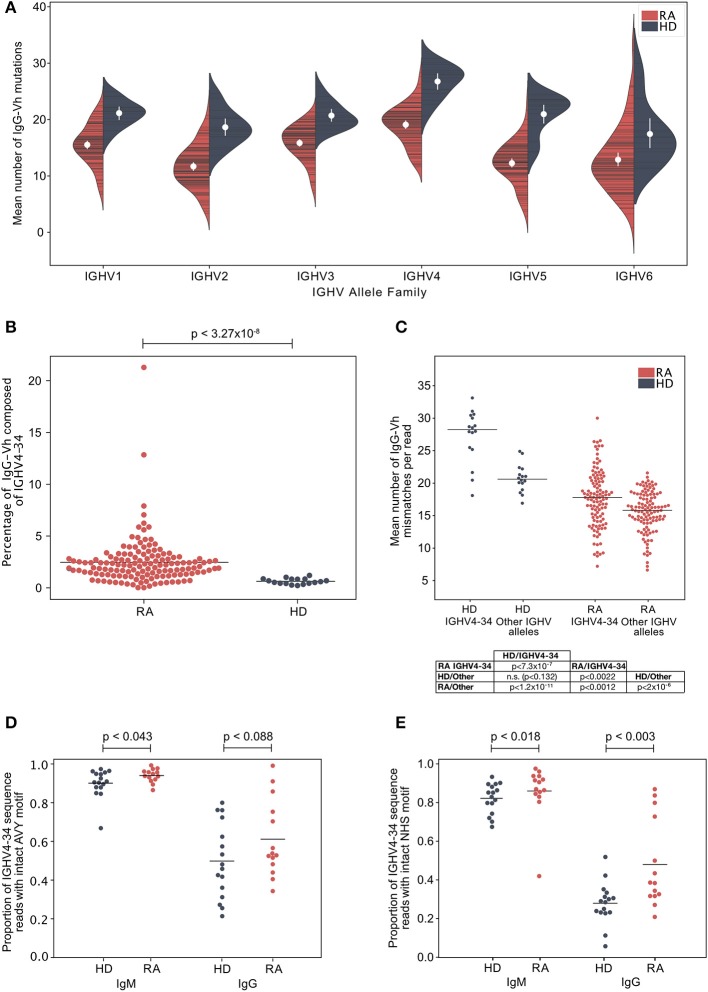
(A) The mean number of IgG-Vh V segment mismatches per read for each individual in the ERA (cohort 2, n = 113) and healthy control groups (cohort 1, n = 16). Data are split by germline IGHV family group. White circles denote group means, vertical white lines show the 95% confidence interval for the mean. (B) Percentage of IgG reads that use the IGHV4-34 allele in ERA patients (cohort 2, n = 113) and control donors (cohort 1, n = 16). Horizontal bars denote group means, and p-values calculated by Mann Whitney U-test. (C) Mean number of IgG-Vh mismatches per read for ERA donors (n = 113, cohort 2) and healthy control donors (n = 16). For each donor, the mean number of mutations for all reads mapping to IGHV4-34, or to other IGHV alleles, were calculated and plotted independently, with horizontal bars plotted to indicate the group mean. P-values calculated using Kruskal Wallis with Dunn's post-hoc pairwise test, and with Holm-Šídák correction for multiple comparisons of group means. (D) Proportion of IGHV4-34 reads of IgM and IgG isotype sequences where the carbohydrate binding AVY motif within framework region 1 (IMGT numbering 24–26) is present. P-value calculated using Mann-Whitney test to compare the group means. (E) Proportion of IGHV4-34 IgM and IgG isotype sequences where the NHS glycosylation motif within CDR2 (amino acid residues 57–59, IMGT numbering scheme) is present. P-value calculated using Mann-Whitney test to compare the group means.